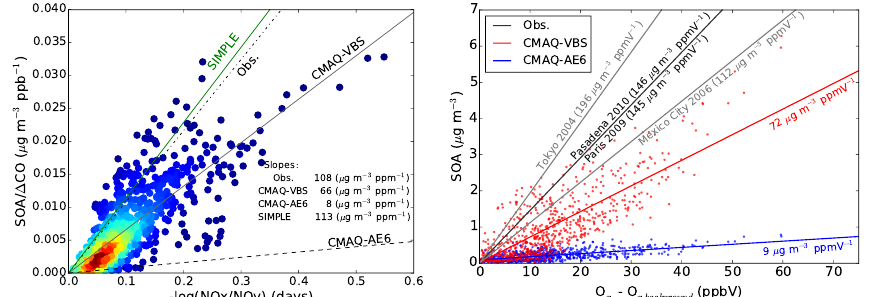
Figure 5. (left) CMAQ-VBS modeled SOA /(cid:49) CO vs. photochemical age [ − log(NO x / NO y )] at Pasadena. Colors indicate the relative density of points determined using the Gaussian density kernel estimate (red corresponds to high density and blue corresponds to low density). Also indicated are the slopes of the best fit lines for the same metric for observations (Hayes et al., 2015), CMAQ-VBS, traditional CMAQ (CMAQ-AE6), and CMAQ with the SIMPLE SOA treatment (Sect. 3.4.3). (right) CMAQ-VBS and CMAQ-AE6 SOA vs. O x (O 3 + NO 2 ) minus O x background at Pasadena. Also plotted are the slopes of the best fit line for the same metric for observations made from a number of urban areas, including Pasadena.